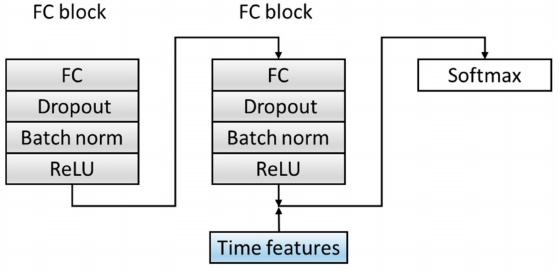
Figure 7. The structure of a classification block. ReLU: Rectified Linear Unit. The convolutional layer and Maxpool layer are represented as Conv_(kernel size)_(kernel number) and Maxpool_(kernel size_(kernel